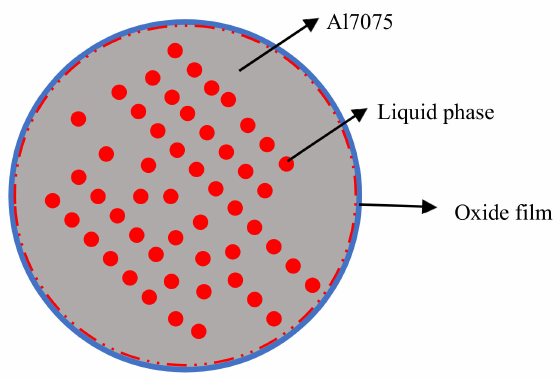
Figure 11. Liquid phase during the Al7075 pre-alloyed powder sintering